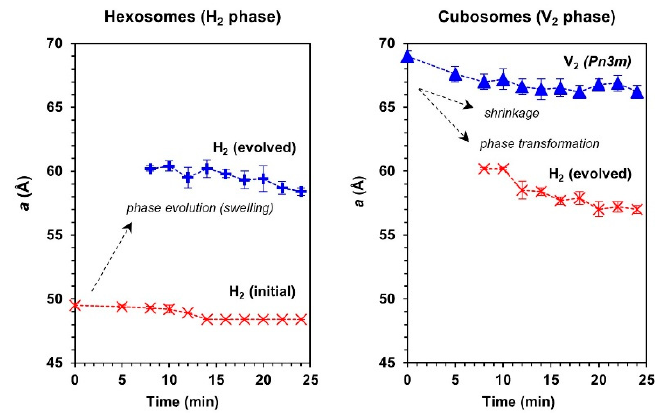
Figure 5. Changes in the mean lattice parameter, a , of hexosomes (left panel) and cubosomes (right panel) in contact with human monocytic cells under circulating flow conditions (27 °C).